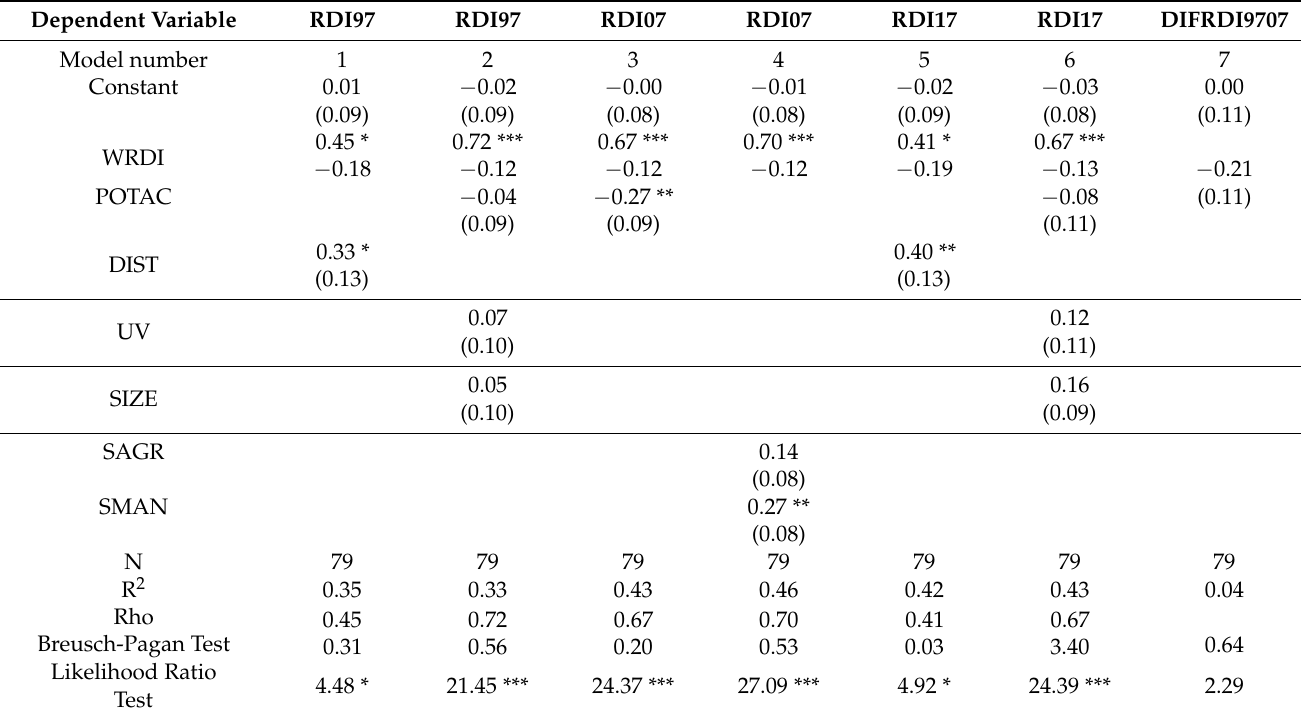
Table 3. Regression models with the RDI SK as the dependent